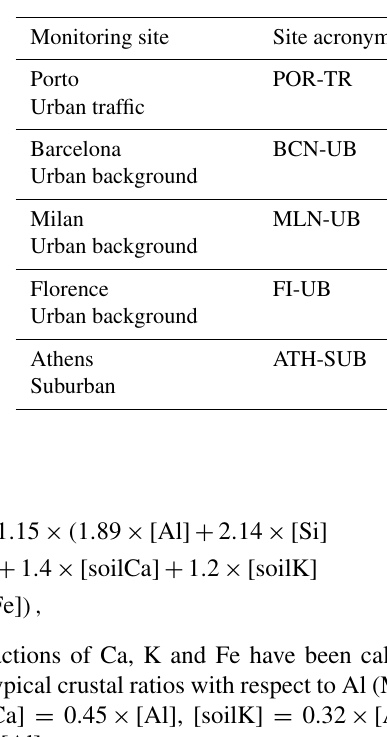
Table 1. Description of measurement campaigns: measurement sites, periods and sampling